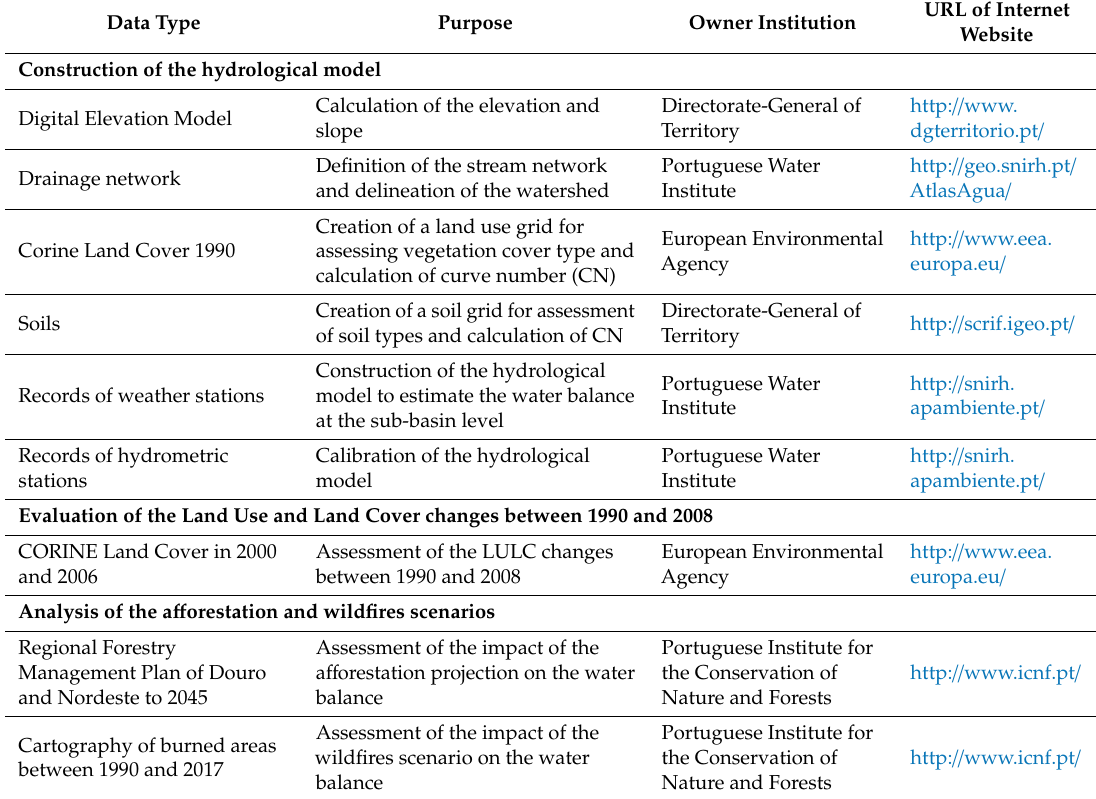
Figure 4. The area burned between 1990 and 2017 in the Sabor river basin. Table 1. Maps and records were used in the construction of the hydrological model, in the evaluation of Land Use and Land Cover (LULC) changes between 1990 and 2008, as well as in the analysis of the afforestation and wildfire scenarios. All data types used have reference to the purpose, their owner institution, and the source of data.